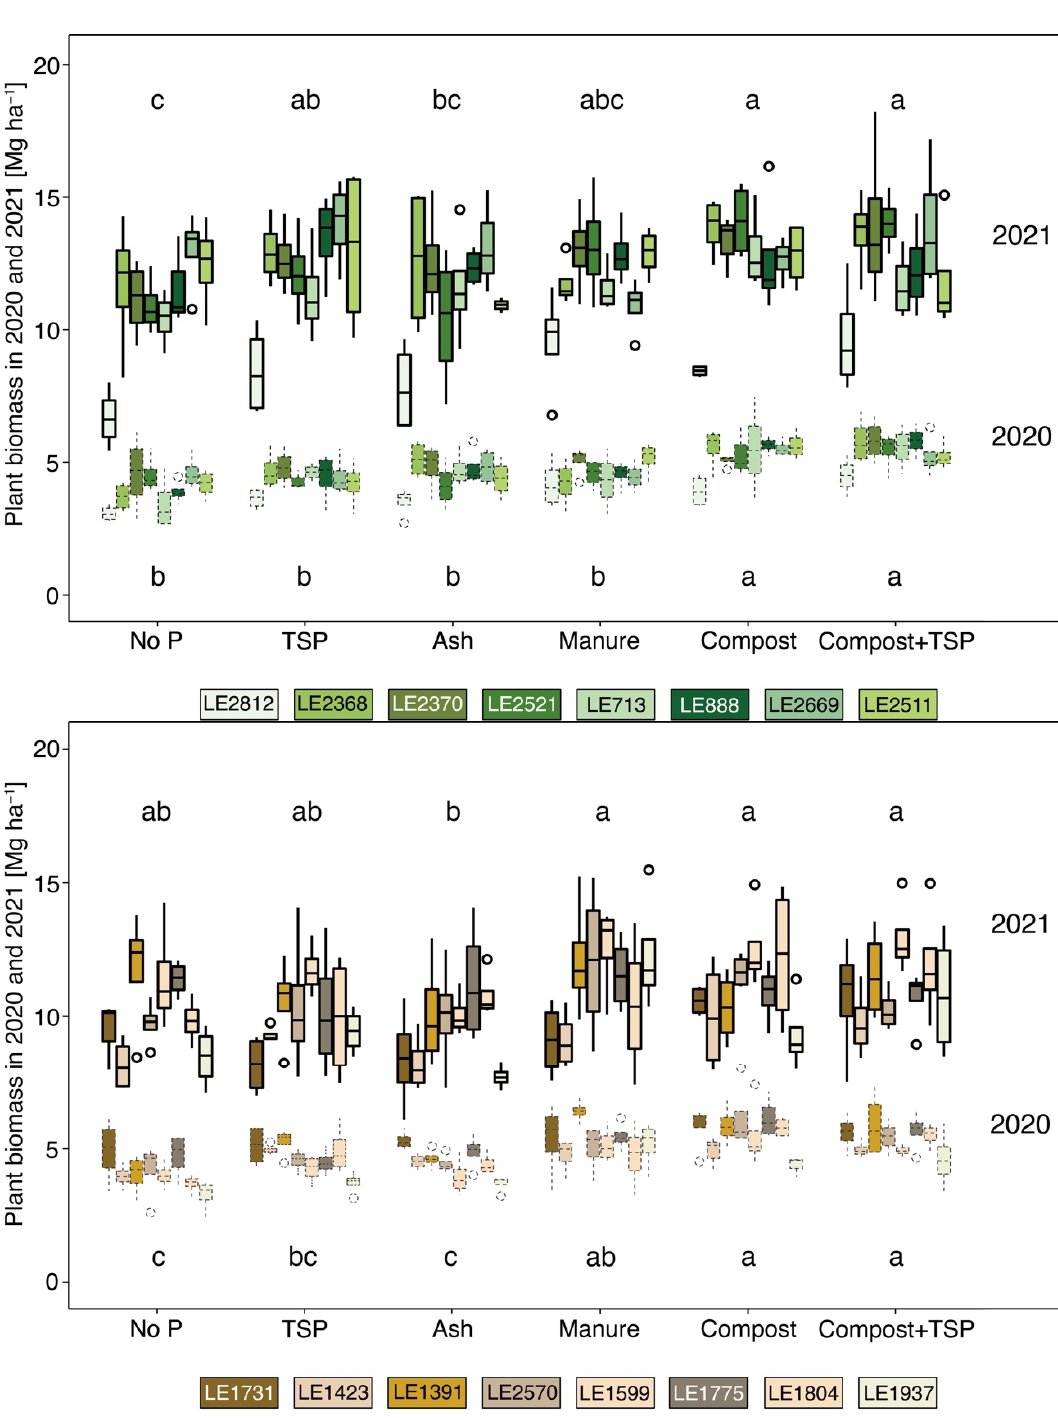
Figure 2. Plant biomass of selected accessions of alfalfa (upper part) and red clover (lower part) of the six studied treatments (no P = without P supply, TSP = triple-super-phosphate, ash = biomass ash, Manure = cattle manure, compost = biowaste compost, and compost + TSP) in 2020 and 2021. Alfalfa and red clover accessions are illustrated in different shades of green and brown colours, respectively. The years 2020 and 2021 are differentiated using dotted and solid lines, respectively. Letters indicate a significant difference between treatments (based on the average of accessions) within the same plant species (Duncan’s new multiple range test with p < 0.05). Mean ± standard deviation (n = 4). The average plant P concentration of red clover (2.76 g kg − 1 ) was slightly but signifi- cantly higher than that of alfalfa (2.62 g kg − 1 ) in 2020 (Table 4), but decreased to the same